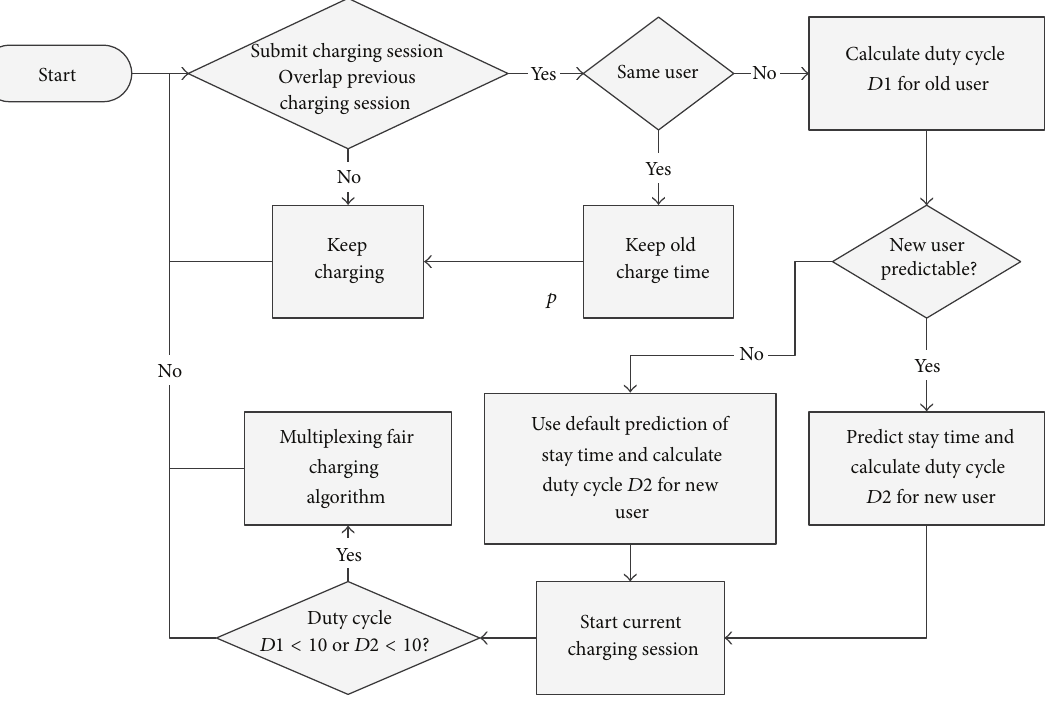
Figure 9: Fair Current Sharing